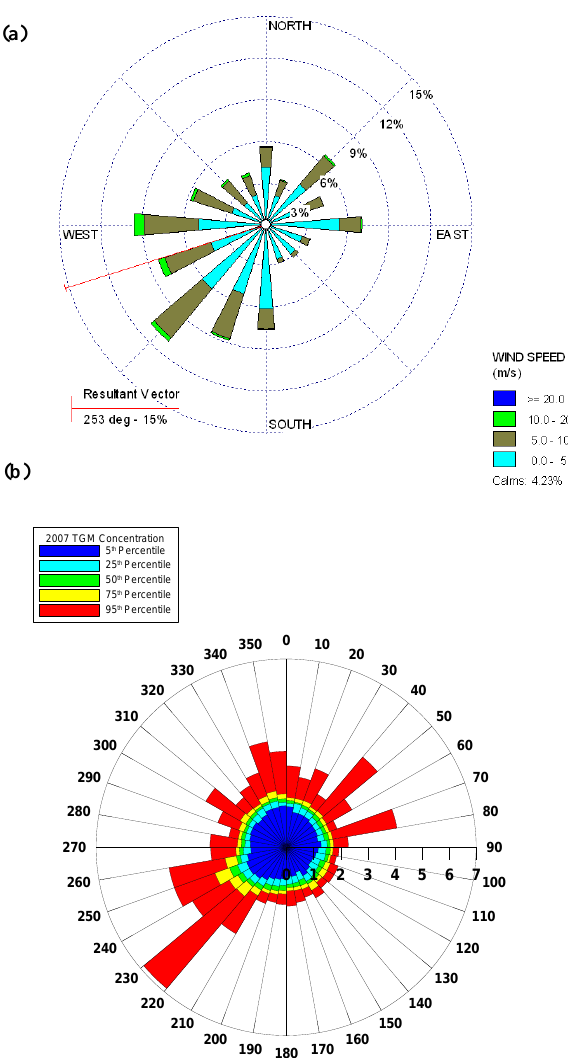
Fig. 2. (a) Wind rose, and (b) Hg pollution rose (ng/m 3 ) for Windsor, 2007, using hourly data.